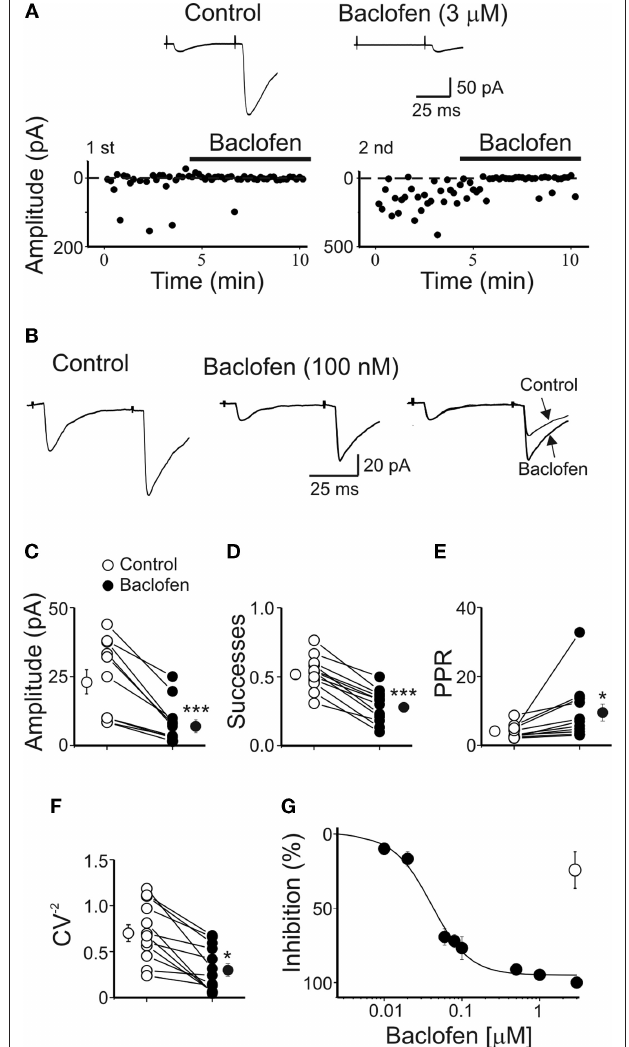
FIGURE 3 | Baclofen reduces the amplitude of MF-evoked GABAergic currents in CA3 principal cells. (A) Peak amplitude of MF-evoked synaptic currents (in response to a fi rst and a second stimulus, at P4) in control and during bath application of baclofen (3 μ M, bars). Note that baclofen completely abolished the response to the fi rst stimulus and strongly depressed the response to the second one. Insets above the graphs represent averaged traces (20 individual samples including failures) in control (left) and during application of baclofen (right). (B) A lower concentration of baclofen (100 nM) reduced the peak amplitude of both fi rst and second responses (each trace is the average of 20 individual samples including failures). On the right, the two traces (on the left and on the middle) are normalized to the fi rst response and superimposed to show baclofen-induced changes in PPR. Summary plots of mean amplitude (C) , success rate (D) , paired-pulse ratio (E) and inverse squared of CV (F) for 12 cells recorded in control (open symbols) and during bath application of baclofen (100 nM, closed symbols). * p < 0.05, *** p < 0.001. (G) Baclofen depressed in P1–P6 pyramidal cells (closed circles) the amplitude of MF-elicited synaptic currents in a dose-dependent way. Each point represents the mean value of three to fi ve individual experiments. Bars are the SEM (they are often within the symbols). Data points were fi tted with the Hill equation (see Materials and Methods; the IC value was 0.04 μ M). 50 The effect of baclofen (3 μ M) was partially prevented by CGP55845 (1 μ M, open circle) ( n =